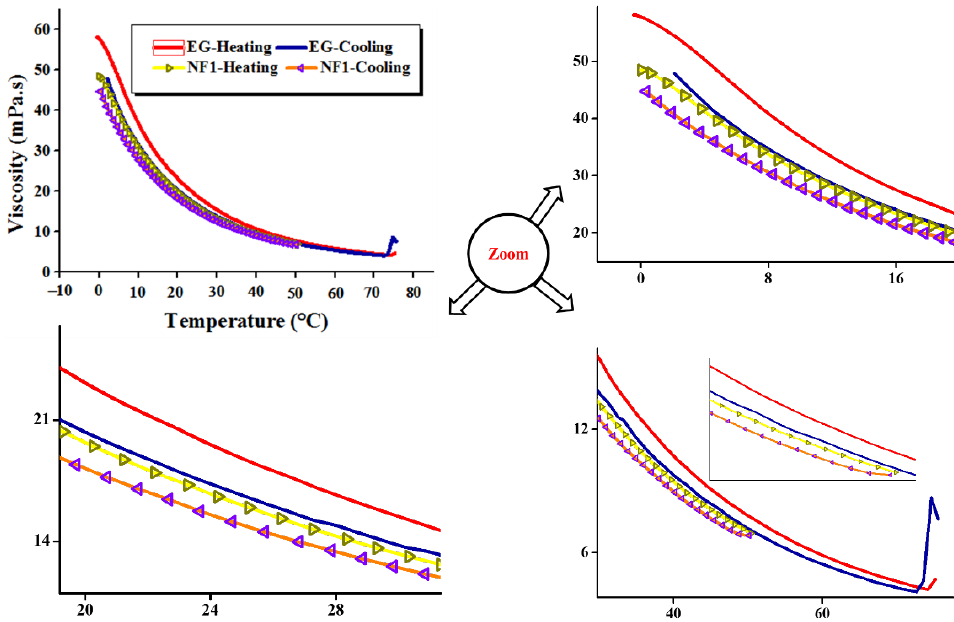
Figure 10. Cycling dynamic viscosity to simulate the true flow behavior of MoS 2 /EG nanofluids in consecutive heating and cooling cycles at a shear rate of 100 s −1 .